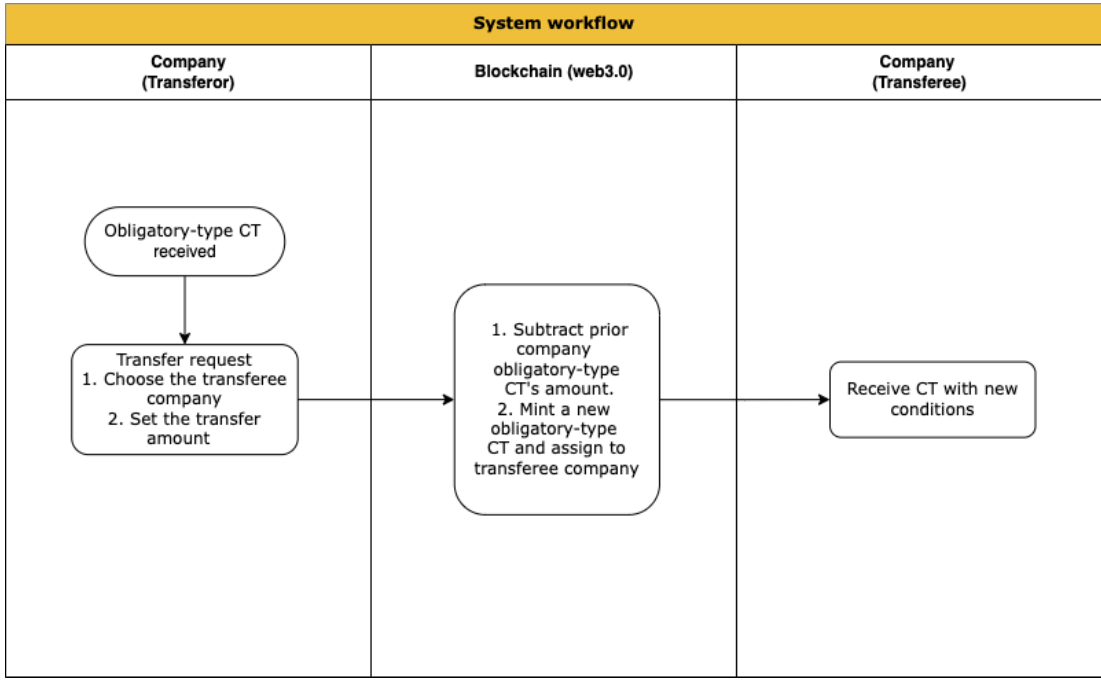
Figure 12. The workflow of transferring and the conversion of CTs